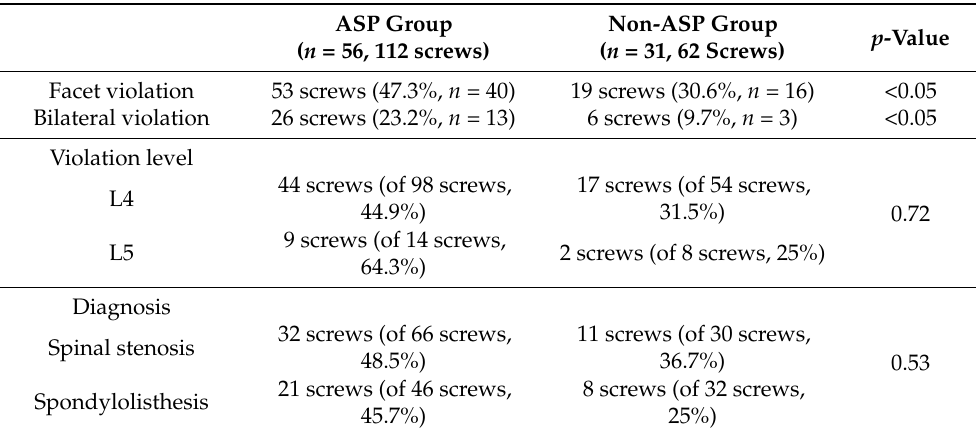
Table 2. Distribution of superior facet joint violations by patient clinical characteristics in the ASP group and non-ASP